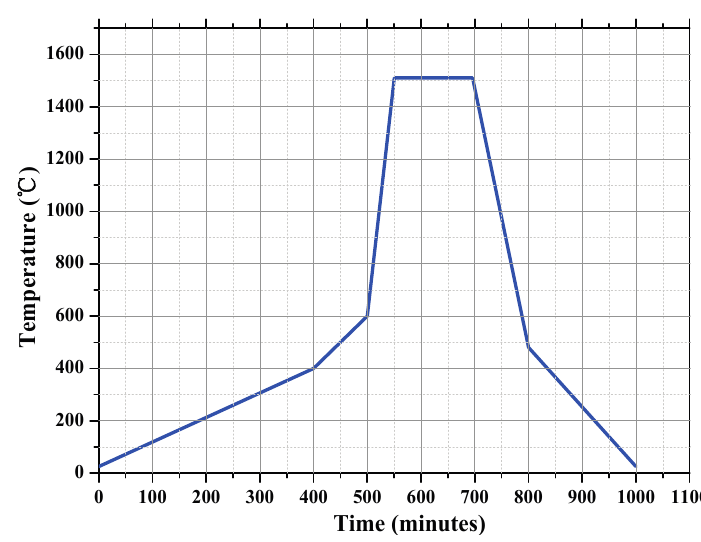
Figure 4. High-temperature sintering curve.